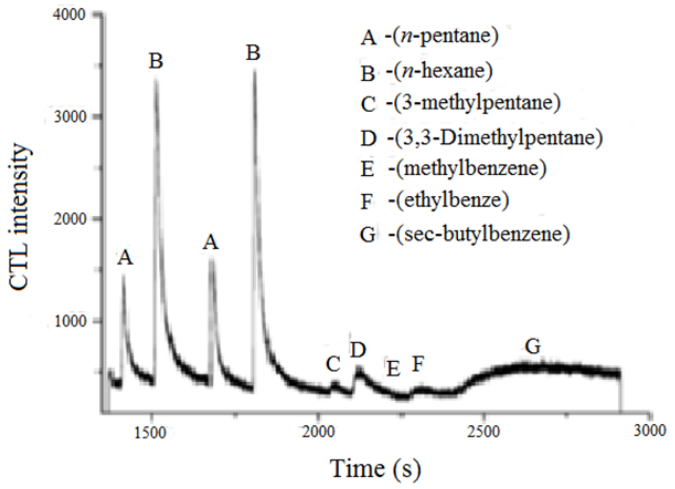
Figure 12. The intensity of cataluminescence for various alkanes, aromatics and alkyl aromatics on CsNaY-2 zeolite, 3.88 μg/mL of analytes, demonstrating sensitivity to n-alkanes (adapted from Reference